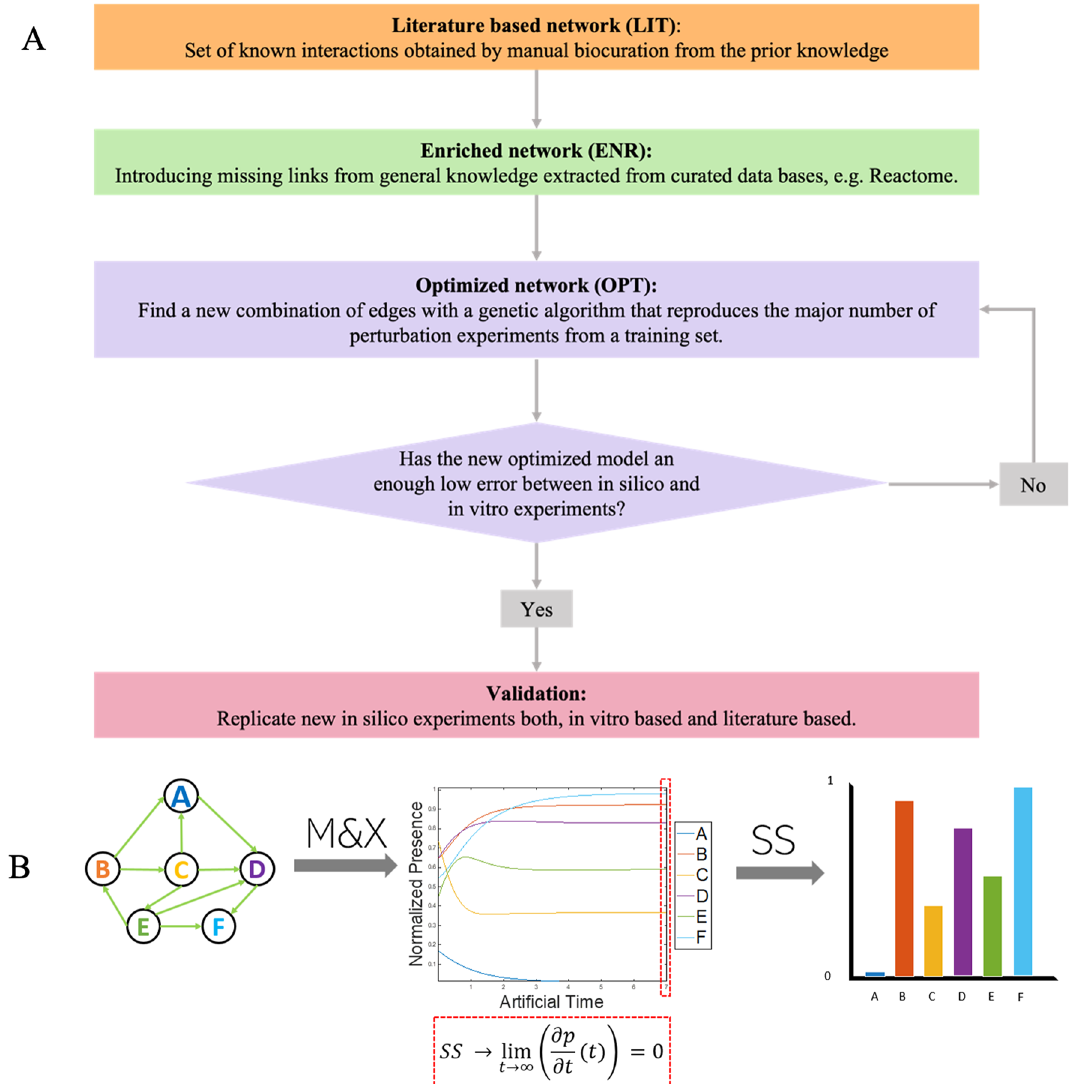
Figure 8. Summarized methodology. ( A ) Workflow for the network design. The literature-based (LIT) network was built from available biological knowledge from specialized journals. Then, STRING 21 was used to complement interactions, obtaining the enriched (ENR) network. Finally, a genetic algorithm (GA) and experimental data were used to tune the node interactions, leading to the optimized (OPT) network. ( B ) Illustration of how the steady state of the system is extracted from the dynamic information provided by the network calculations. (M&X is an acronym for the Mendoza et al. 25